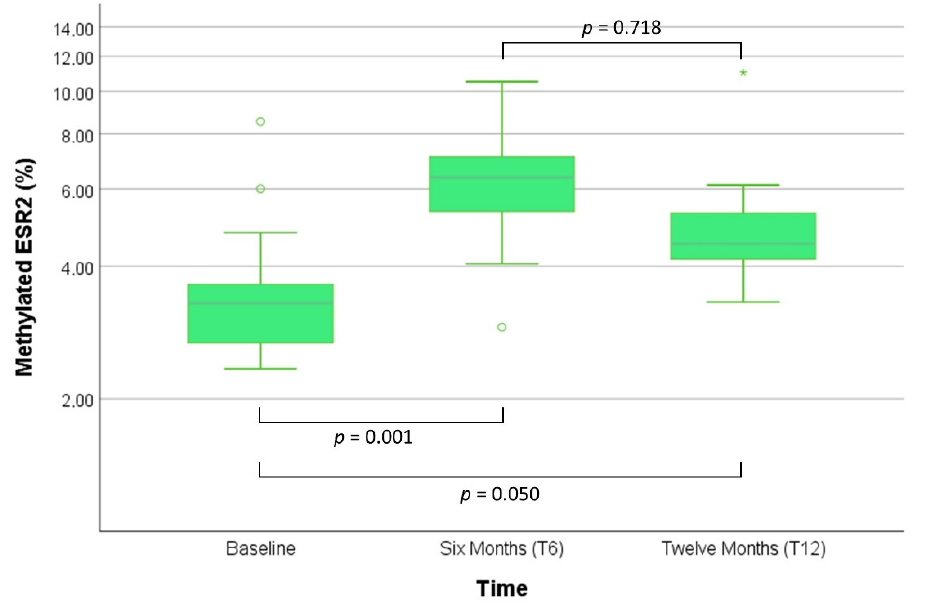
Figure 3. ESR2 methylation percentage at baseline and after gender assignment hormone therapy (T6 and T12). Friedman’s test. p -values are Bonferroni adjusted.